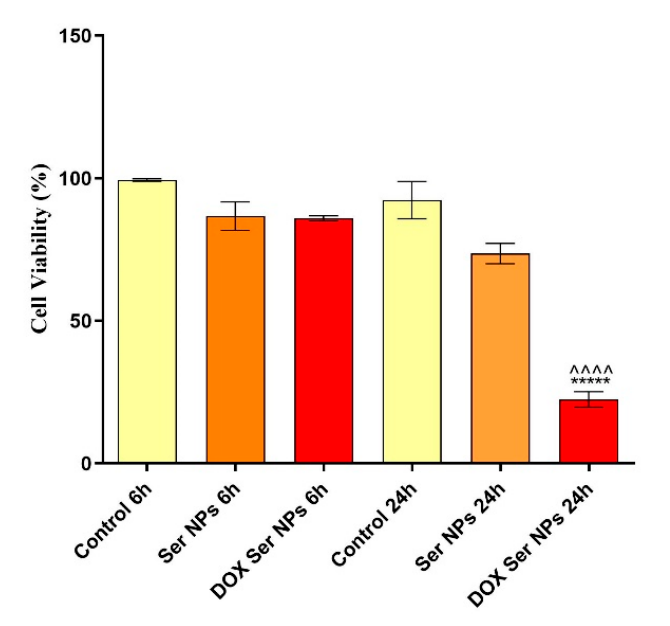
Figure 10. Graphical representation of MCF-7 breast cancer cells viability after 6 h and 24 h of treatment with free and DOX-loaded Ser NPs (Dox Ser NPs vs. untreated control **** p ≤ 0.0001; Dox Ser NPs vs. Ser NPs ^^^^ p ≤ 0.0001) .